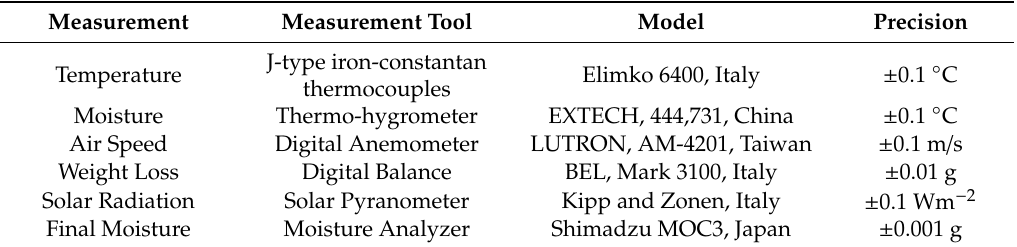
Table 2. Measurement